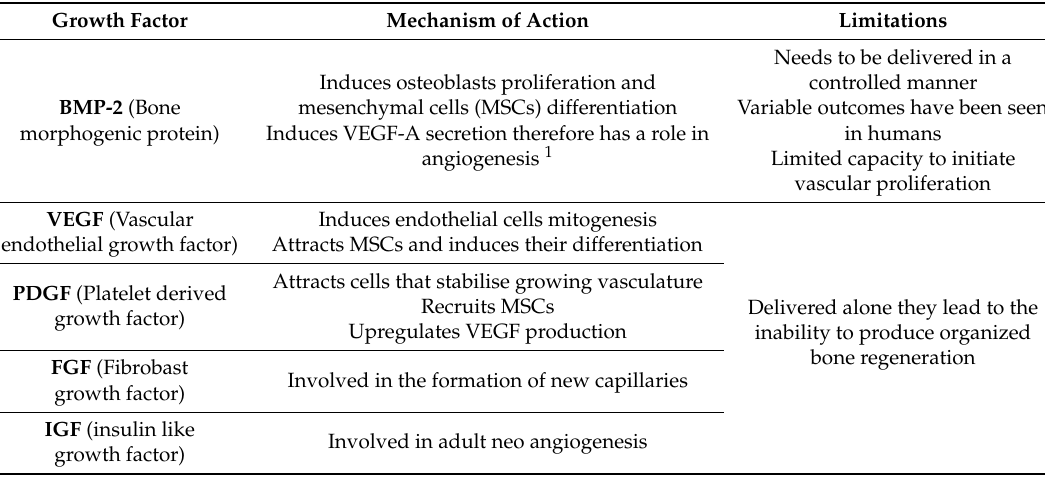
Table 2. Growth factors employed in bone tissue engineering applications